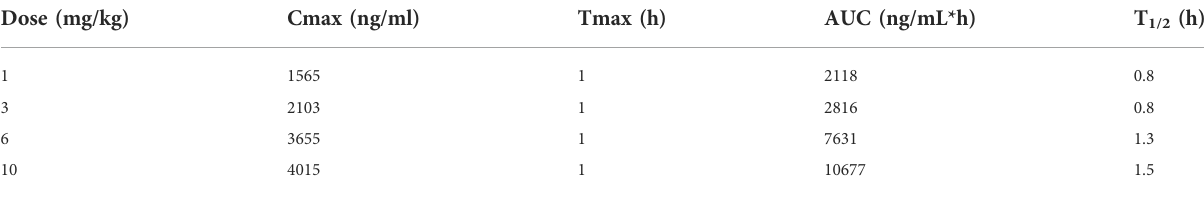
TABLE 1 PK parameters of fb-PMT in